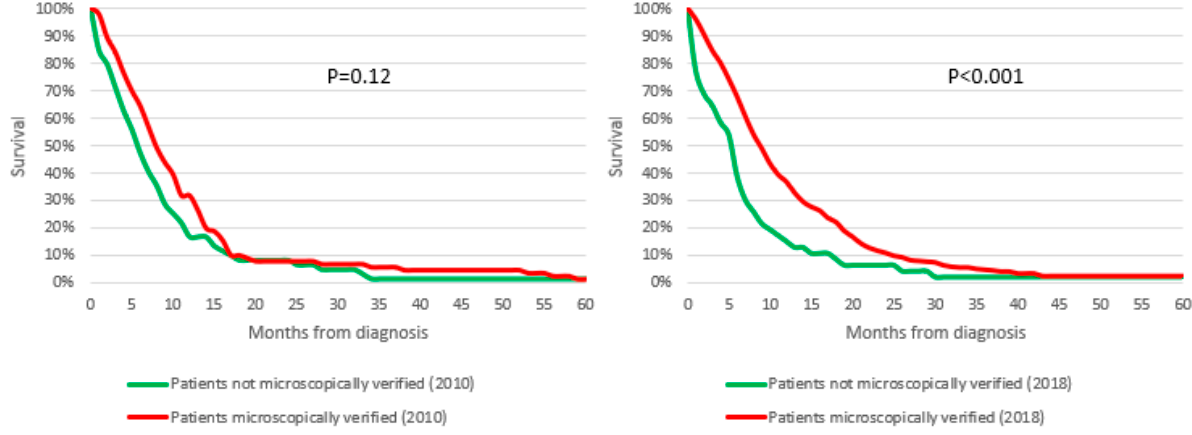
Figure 6. Survival of Stage III ‐ IV pancreatic cancer patients of the Veneto region population who underwent chemotherapy alone according to diagnostic confirmation and year.